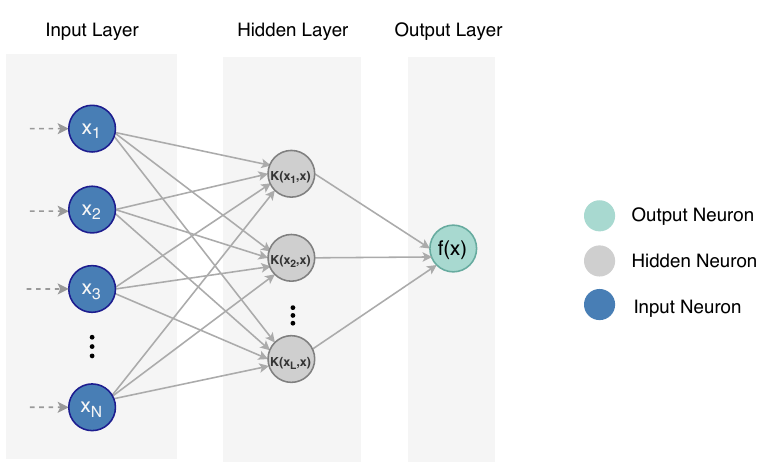
Figure 2. A structural representation of the KELM